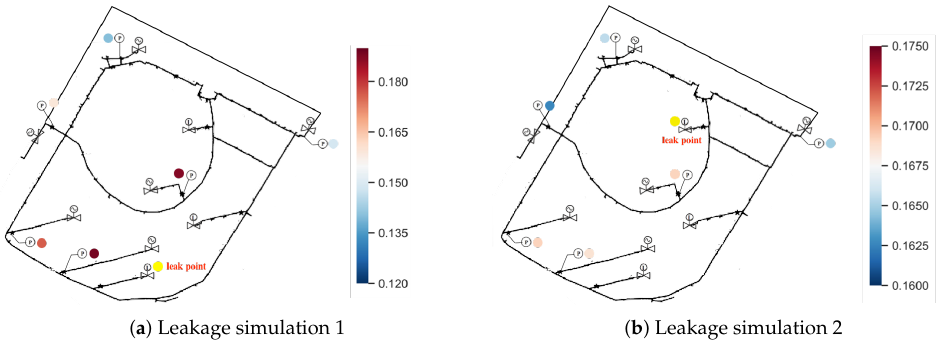
Figure 14. Coefficients of multiple pressure sensors with leak at different